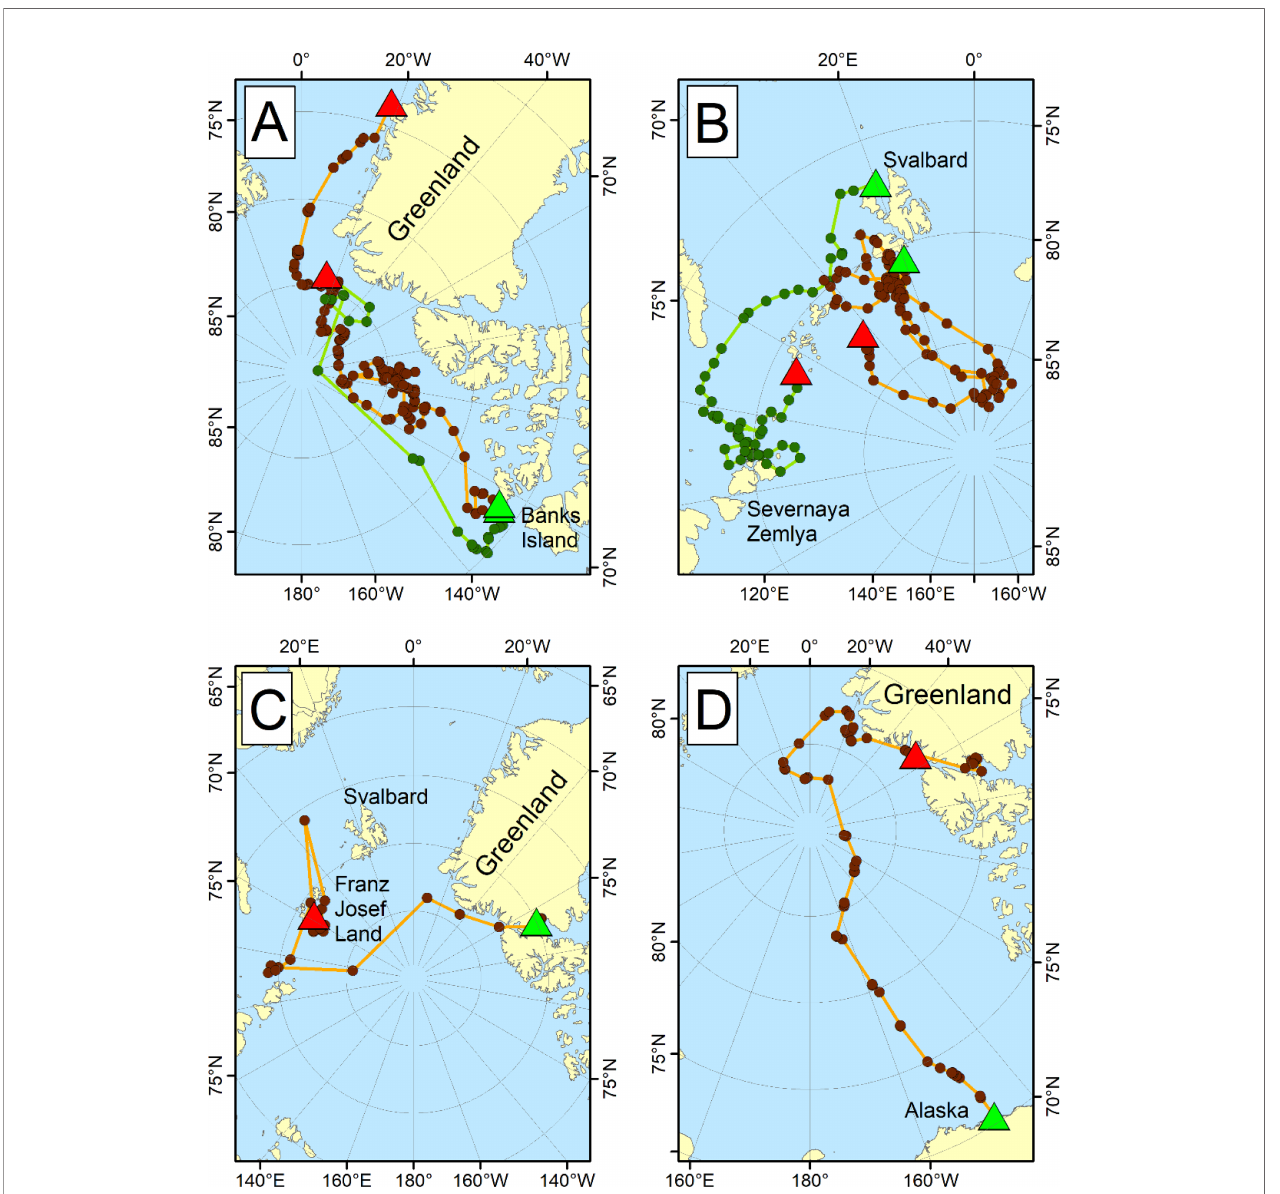
FIGURE 5 | Long-distance movements of satellite-collared adult female polar bears across subpopulation boundaries, with green triangles showing start locations and red triangles showing end locations. Data shown for (A) two bears tagged in the Northern Beaufort Sea, one of which traveled to northern Greenland from May to October 1993 (green dots), and the other to eastern Greenland from April 1993 to February 1995 (brown dots; Lunn et al., 1995); (B) two bears tagged in the Barents Sea, one of which moved from Svalbard to Severnaya Zemlya in the Kara Sea from April to November 2013 (green dots), and another that moved from Svalbard into the Arctic Basin from April 2014 to September 2015 (brown dots; Aars, unpublished data); (C) one bear tagged in Kane Basin between April 2013 and 2015 crossed the Arctic Basin to Franz Josef Land in the Barents Sea (Laidre et al., 2020b); and (D) one bear tagged in the Southern Beaufort Sea between May 1992 and December 1993 traveled across the Arctic Basin to Greenland (Durner and Amstrup, 1995). Distances moved by polar bears in these fi gures are upwards of 3,500 km across the polar